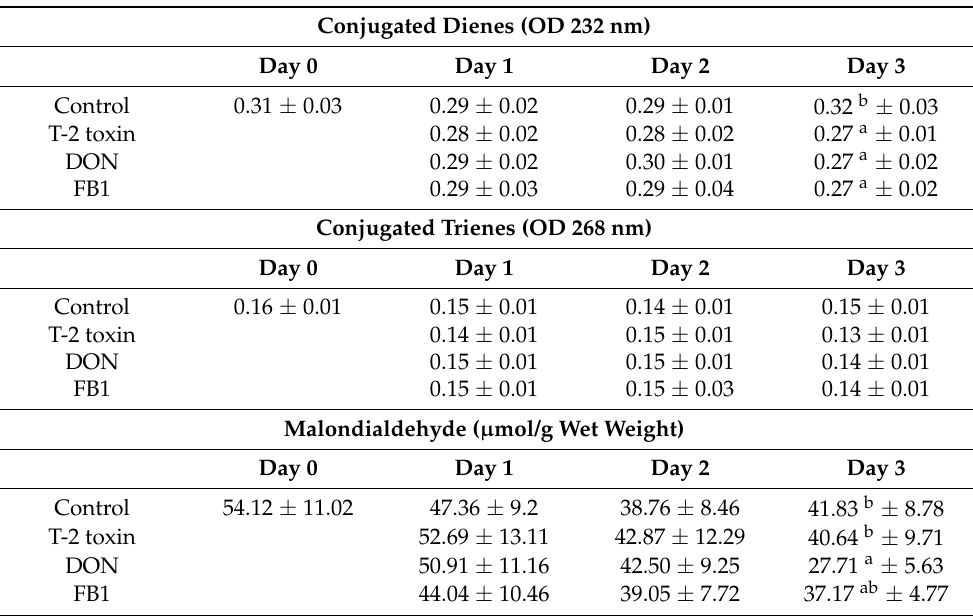
Table 5. Short-term effect of T-2 toxin, deoxynivalenol (DON), and fumonisin B 1 (FB1) treatment on the parameters of lipid peroxidation in liver of laying hens (mean ± S.D.; n = 6).